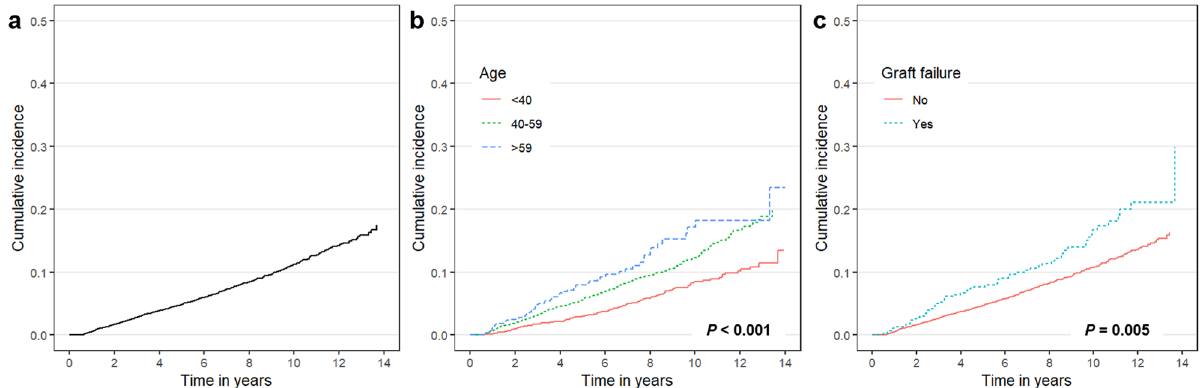
Figure 1. Cumulative incidence rate of post-transplant malignancy after kidney transplantation. ( a ) Total incidence. ( b ) Older age and ( c ) graft failure were associated with post-transplant